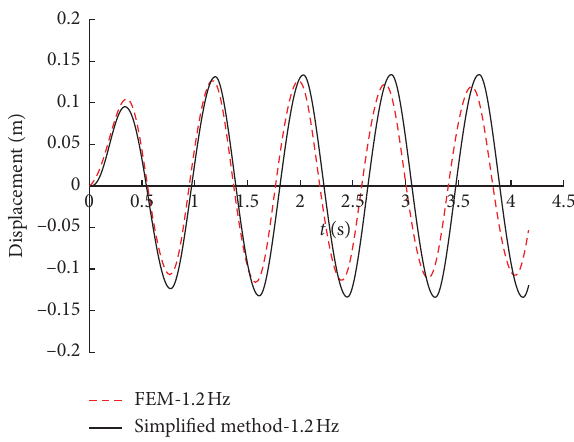
Figure 8: Time histories of lateral displacement atop the caisson after scouring. Table 2: Working conditions of